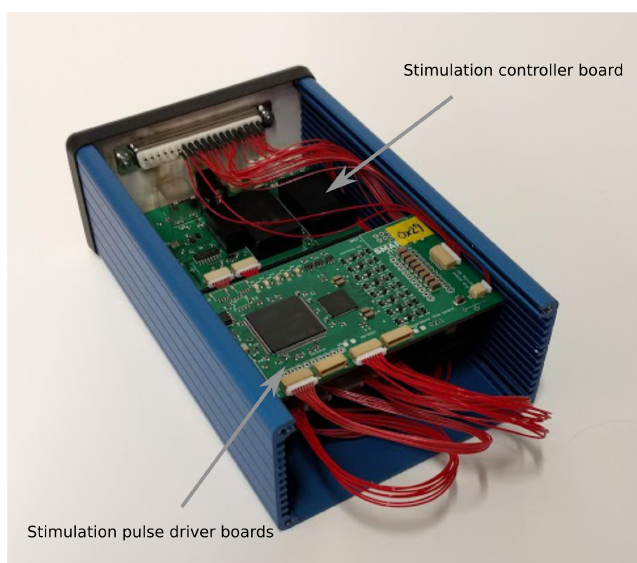
Figure 3. Interior of custom stimulation unit.